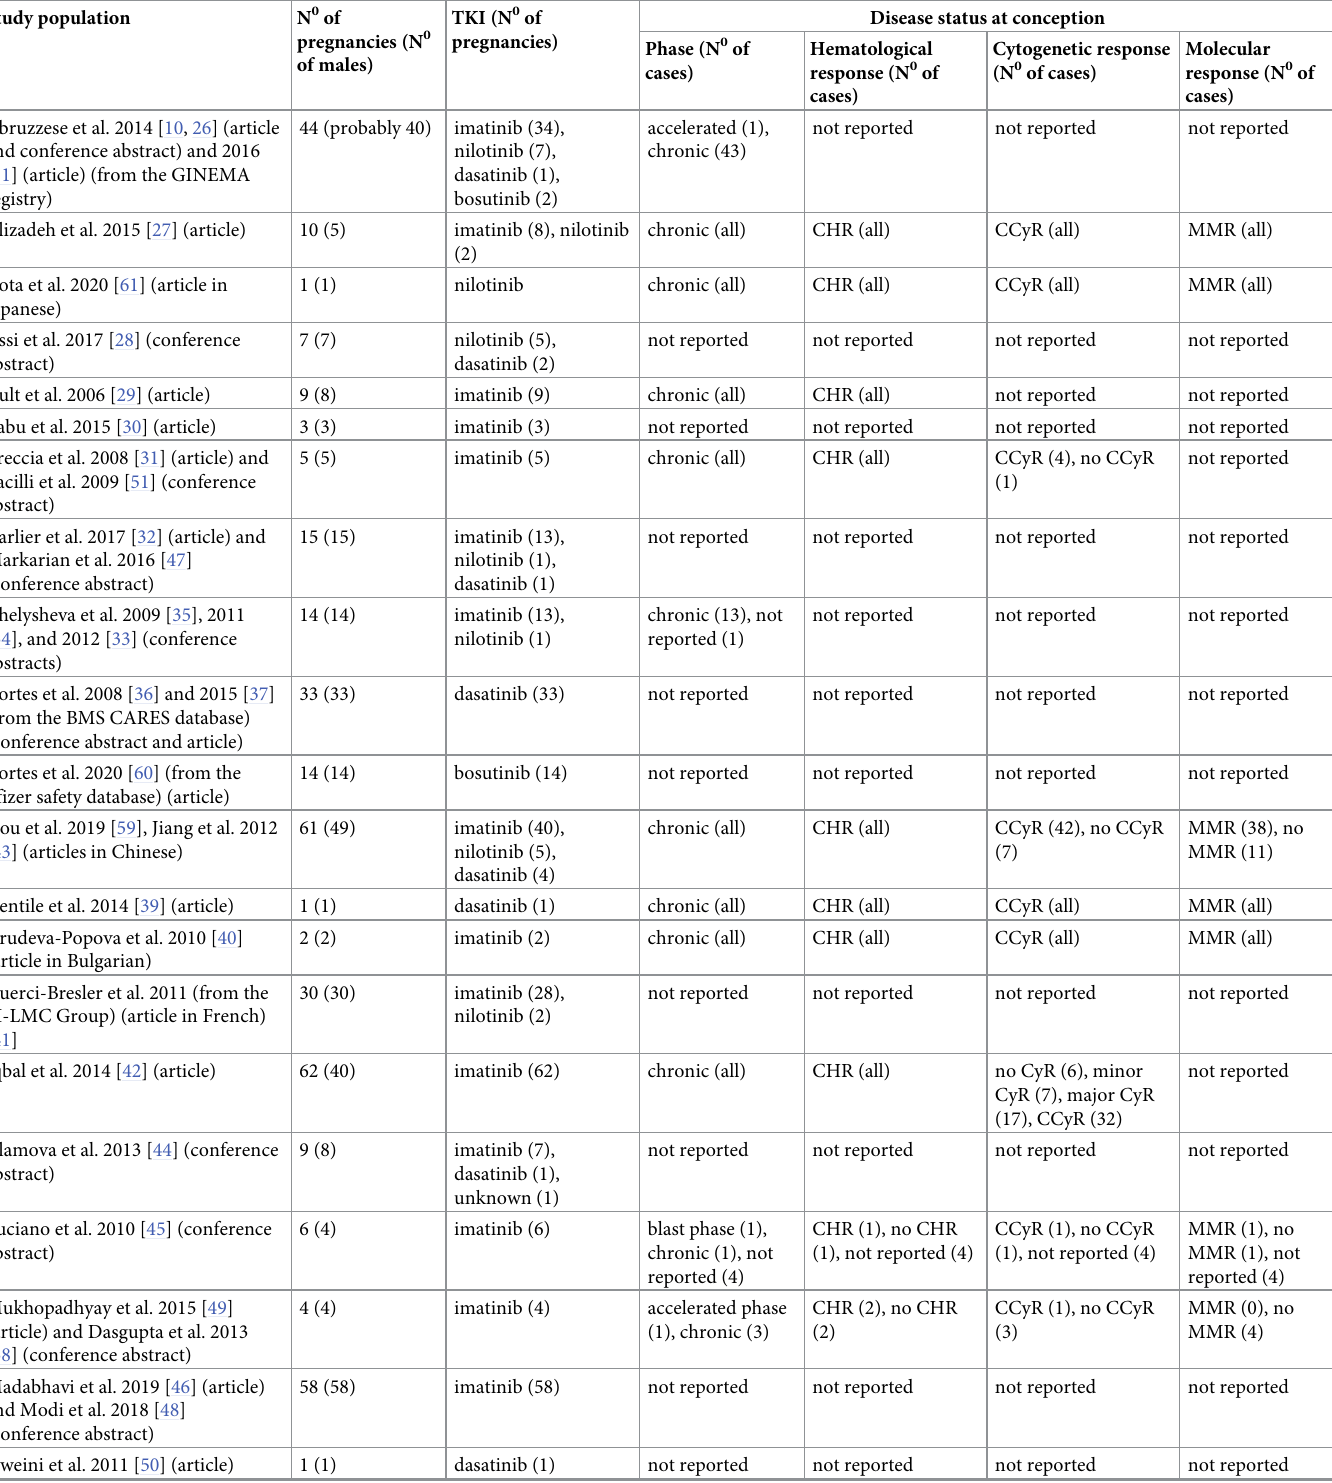
Table 3. CML status at conception in males with no treatment